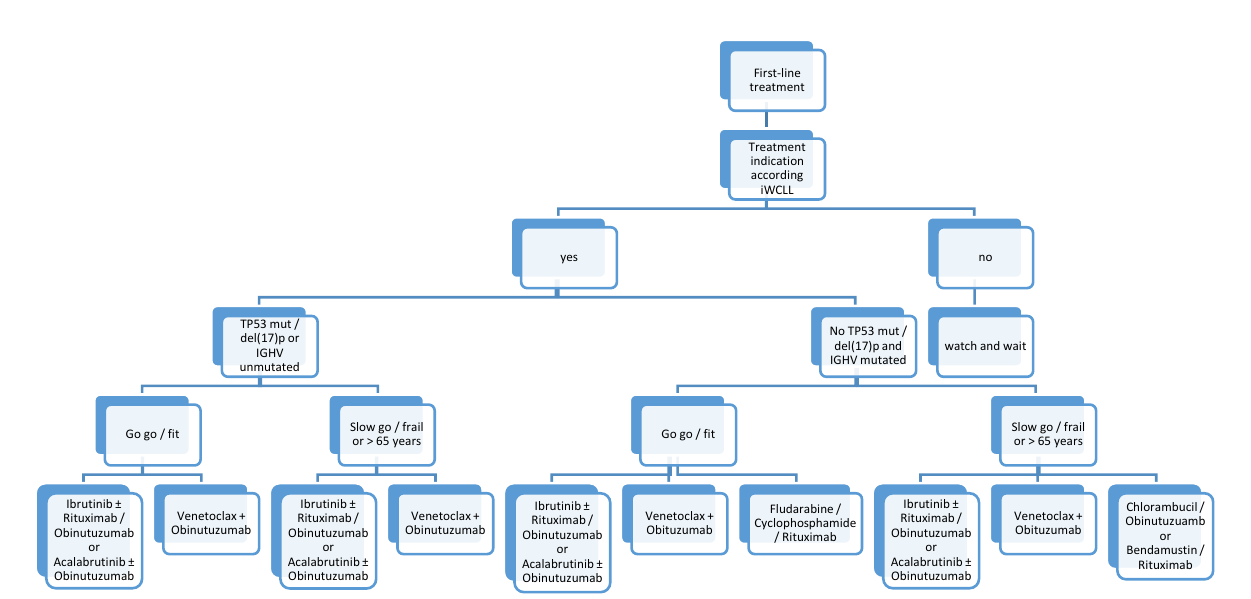
Figure 1. Frontline treatment algorithm in CLL. Nevertheless, even though novel agents might be the standard of care, CIT (chlorambu- cil/obinutuzumab, bendamustine/rituximab or FCR) is still an available treatment option in tn IGHV-mutated CLL patients without del(17p), TP53 mutation, or complex karyotype. 13. Treatment in Relapsed/Refractory Patients Similar to first-line therapy, r/r CLL should only be treated if symptomatic according to the International Workshop Group on CLL (iwCLL) criteria [4]. As with tn nCLL patients, novel therapeutics are superior to CIT regimens, leading to significantly better survival in r/r CLL patients [4,127]. Both combination treatment with venetoclax + rituximab and BTKis are feasible treatment options in r/r CLL patients (Figure 2 and Table 2). We suggest that re-treatment with venetoclax + rituximab might also be a feasible treatment option if patients had a long duration of response without disease progression after first-line treatment with venetoclax + obinutuzumab (e.g., after 53.9 months, which